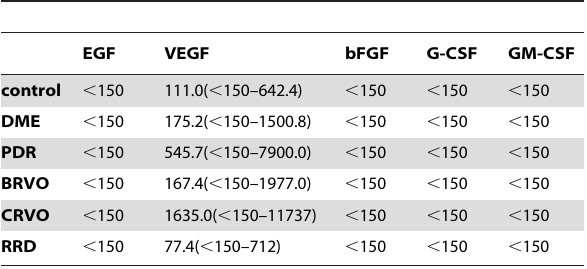
Table 4. Concentrations of growth factors in the vitreous cavity.